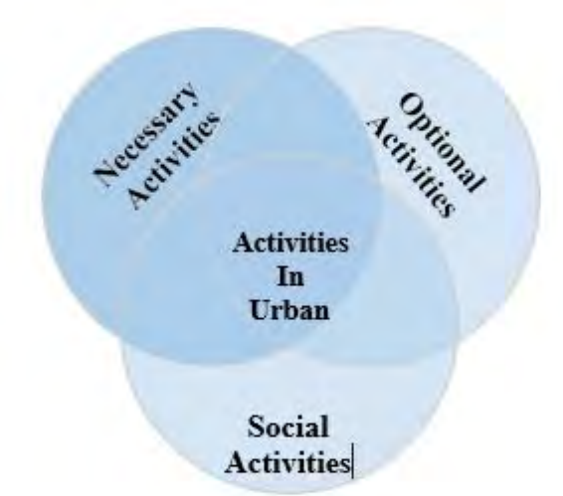
Figure 6. Activities in urban spaces (Gail, 1987. Adapted by the researcher)